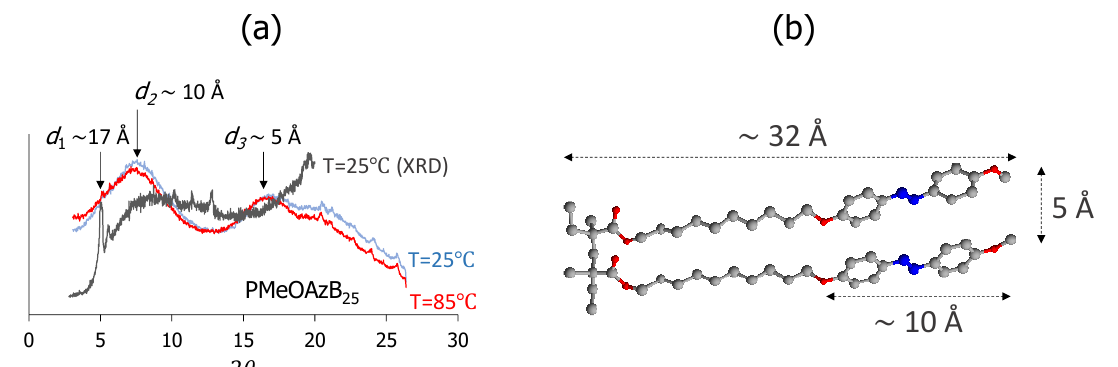
Figure 4. ( a ) SAXS scatterings (in the liquid crystal phase, red curve at T = 85 °C; and in the glass phase, blue curve, T = 25 °C) and XRD diffractogram (grey curve, T = 25 °C) of the mesogenic homopolymer PA, highlighting relevant reflections and their corresponding distances; ( b ) molecular model of two contiguous MeOAzB side chains.